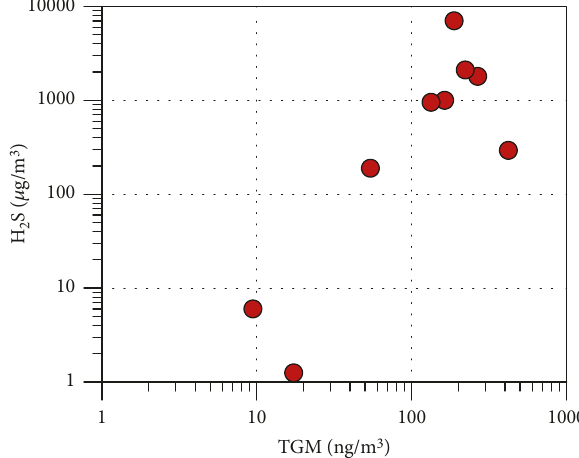
Figure 2: Total gaseous mercury in the atmosphere vs. atmospheric H S concentrations. H 2